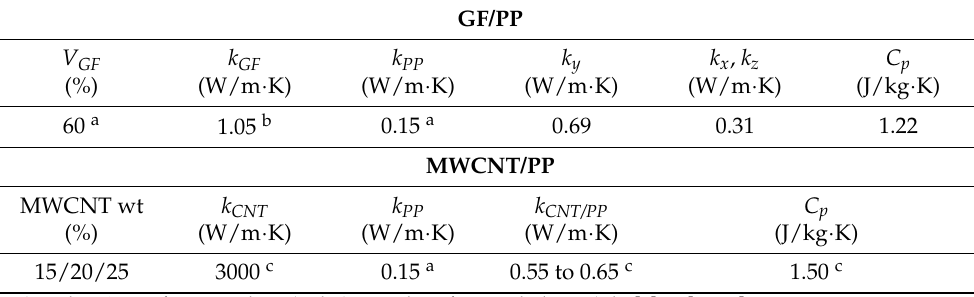
Figure 4. ( a ) Boundary conditions for finite element analysis used for prediction of temperature profile through the thickness of GF/PP joint. Symmetry was assumed along the ZY plane; and ( b ) Example of 3D thermal plot with location of plotted results at the mid-plane, along x-direction at center of bond line. Table 1. Main estimated GF/PP adherend and MWCNT/PP films thermal properties used in FEA. Refer to Figure 4a for coordinate